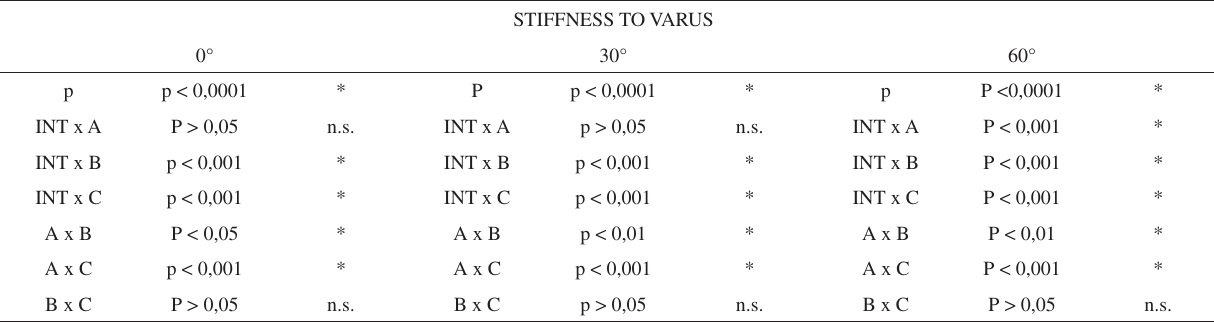
Table 4 - Comparative table and p values for the situations in varus testing to